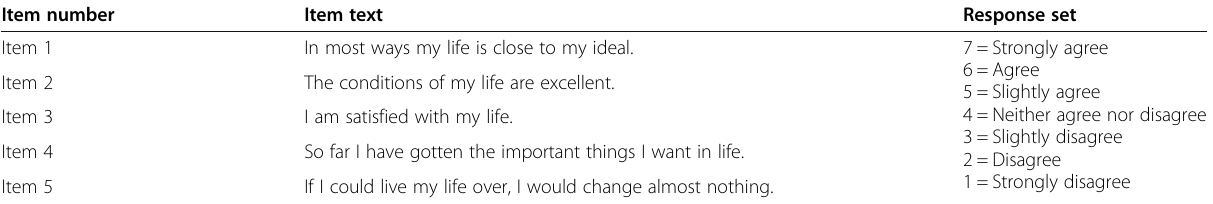
Table 1 Satisfaction with life scale items and response